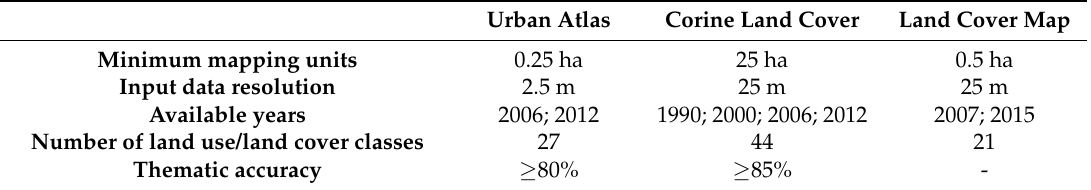
Table 1. Attributes of commonly used processed datasets covering urban areas in the United